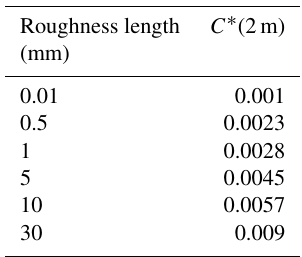
Table 3. Variation in the transfer coefficient C ∗ (2m) for typical val- ues of the roughness length z 0